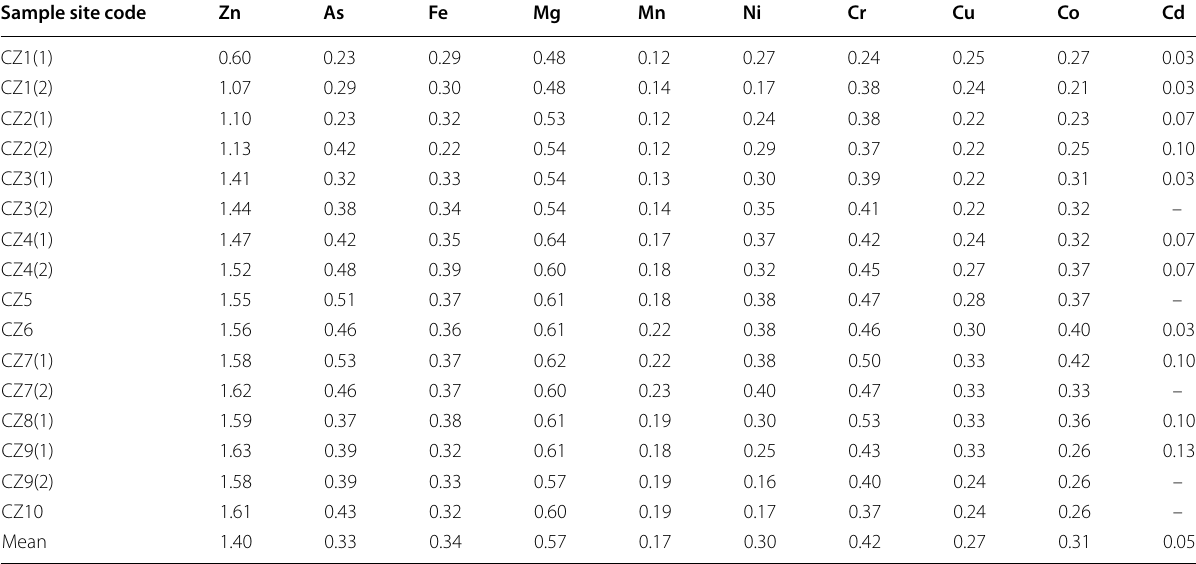
Details of sample site codes are mentioned in the materials and methods section